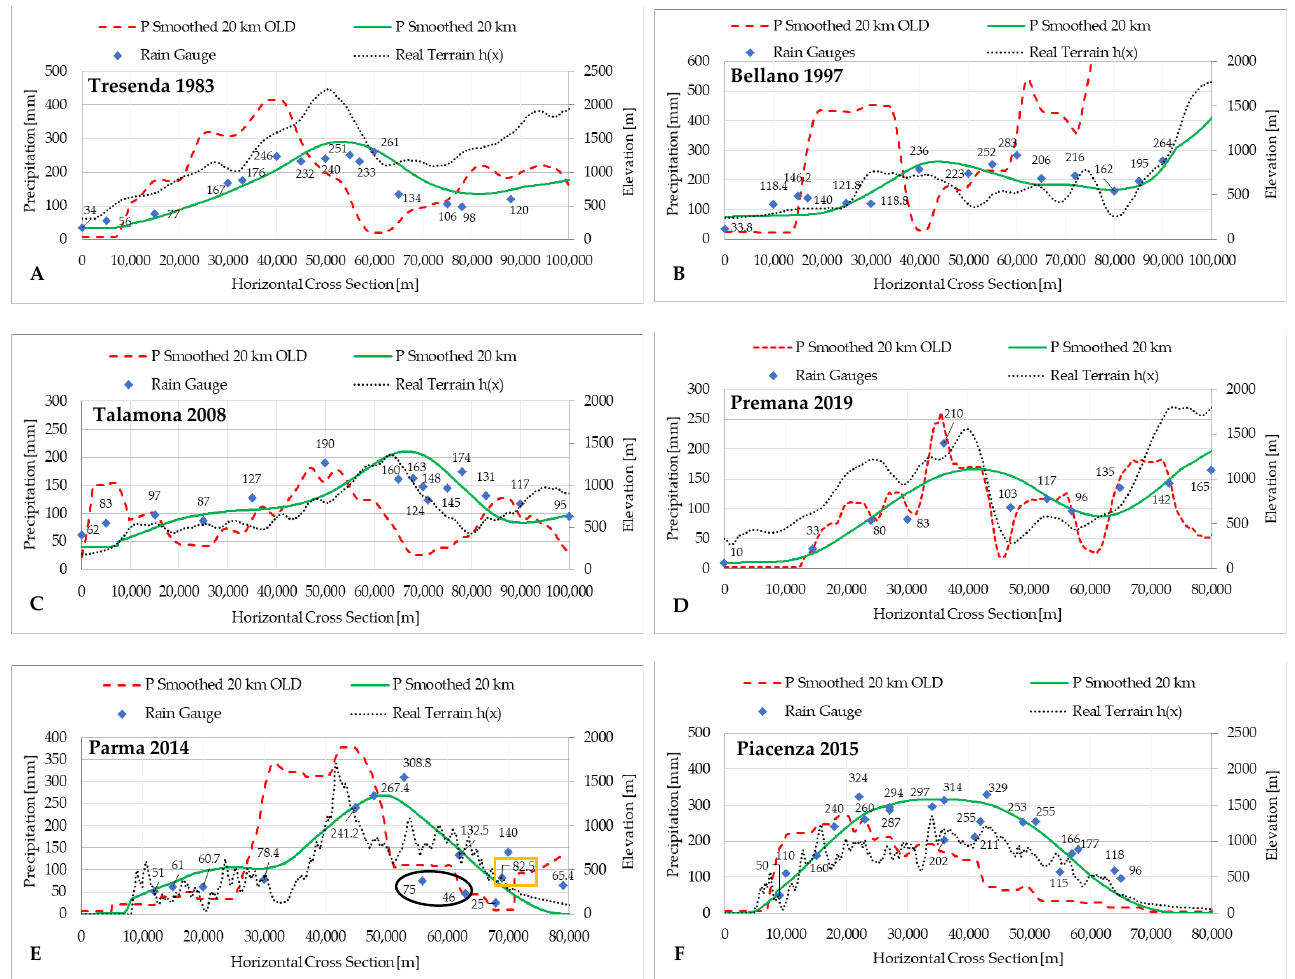
Figure 6. Graphical depiction of selected case studies area over northern Lombardy (Central Alps) from ( A ) to ( D ), and Emilia (northern Apennines) from ( E ) to ( F ). Graph ( A ) depicts the Tresenda 1983 event, ( B ) the Bellano 1997 event, ( C ) the Talamona 2008 event, ( D ) the Premana 2019 event, ( E ) the Parma 2014 event and ( F ) the Piacenza 2015 event. In each graph, the x-axis represents the progression of the orographic trace depicted by a black dotted line. The blue dots represent the rain gauge amount along the traces, while the green line represents the precipitation simulated by LUME. The dotted red line shows the model simulation caried out with the previous version of the upslope model LUM described in [16]. In the six pictures can be appreciated the difference between LUM and LUME simulations. In almost all cases, the former has improved the reconstruction of the rainfall distribution if compared to the ground-based rain gauges records. With respect to the LUM version, unphysical oscillation of precipitation distribution is reduced and smoothed by time-delay coefficients, especially for ( B , D ) events. In graph ( E ), within the black circle, the suspected rain gauge outliers are highlighted, and they are also included in Figure 3. In the orange square, the “fictitious rainfall station” obtained is computed as an average between Calestano station (140 mm) and Campora di Sasso station (25 mm), which are located about 15 km from each other but on the same transversal section along the trace. Here can be appreciate the uncertainties still embedded in the LUME model in the reconstruction of the rainfall dynamics along the lee side of the mountain range where larger errors are committed also for other events studied, especially ( A , C